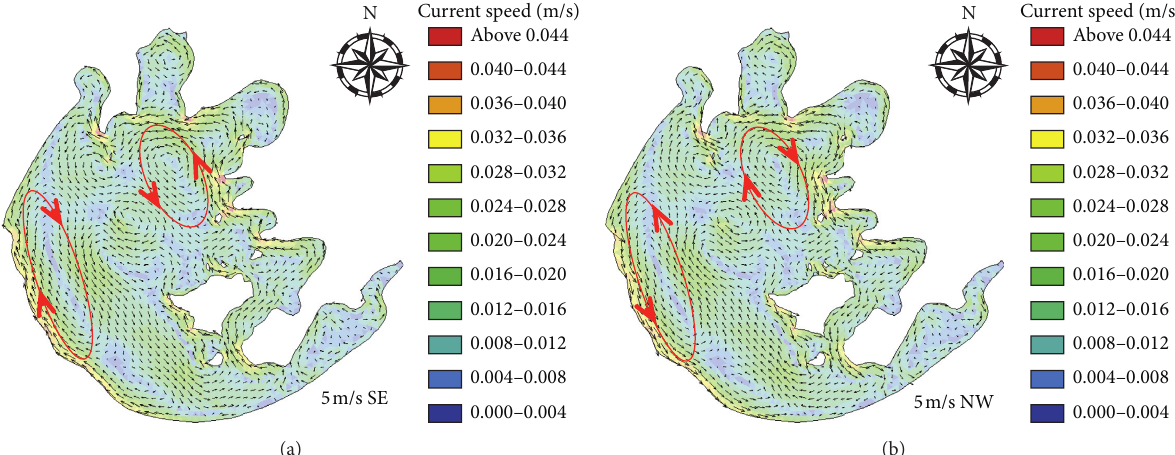
Figure 5: Verification of flow fields with winds at 5m/s from the (a) southeast and (b)